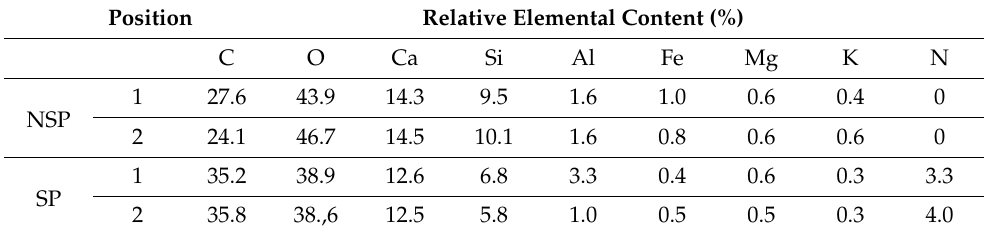
Table 3. Relative elemental composition of samples’ surfaces analysed with EDS.